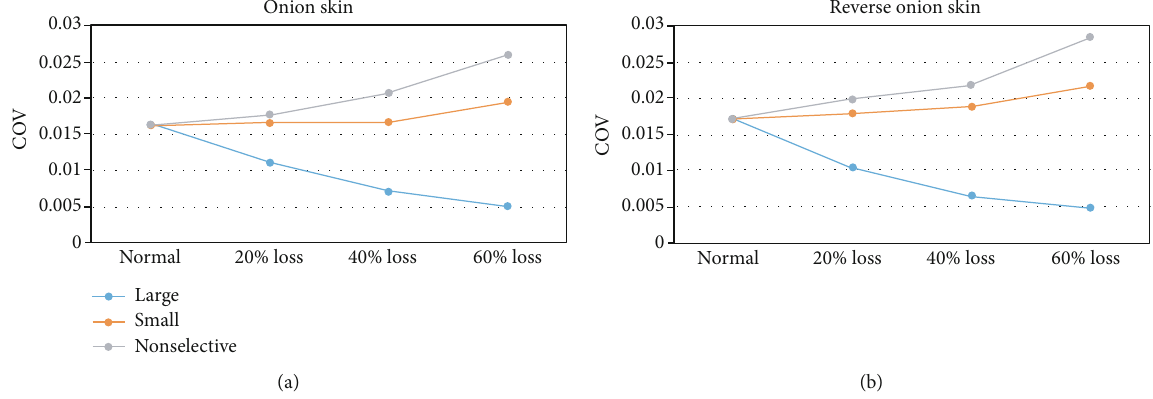
Figure 5: The coe ffi cient of variation (COV) of the simulated maximum muscle force output (i.e., at 100% excitation) for di ff erent patterns and levels of motor unit loss in (a) the “ onion skin ” and (b) reverse “ onion skin ” motor unit fi ring